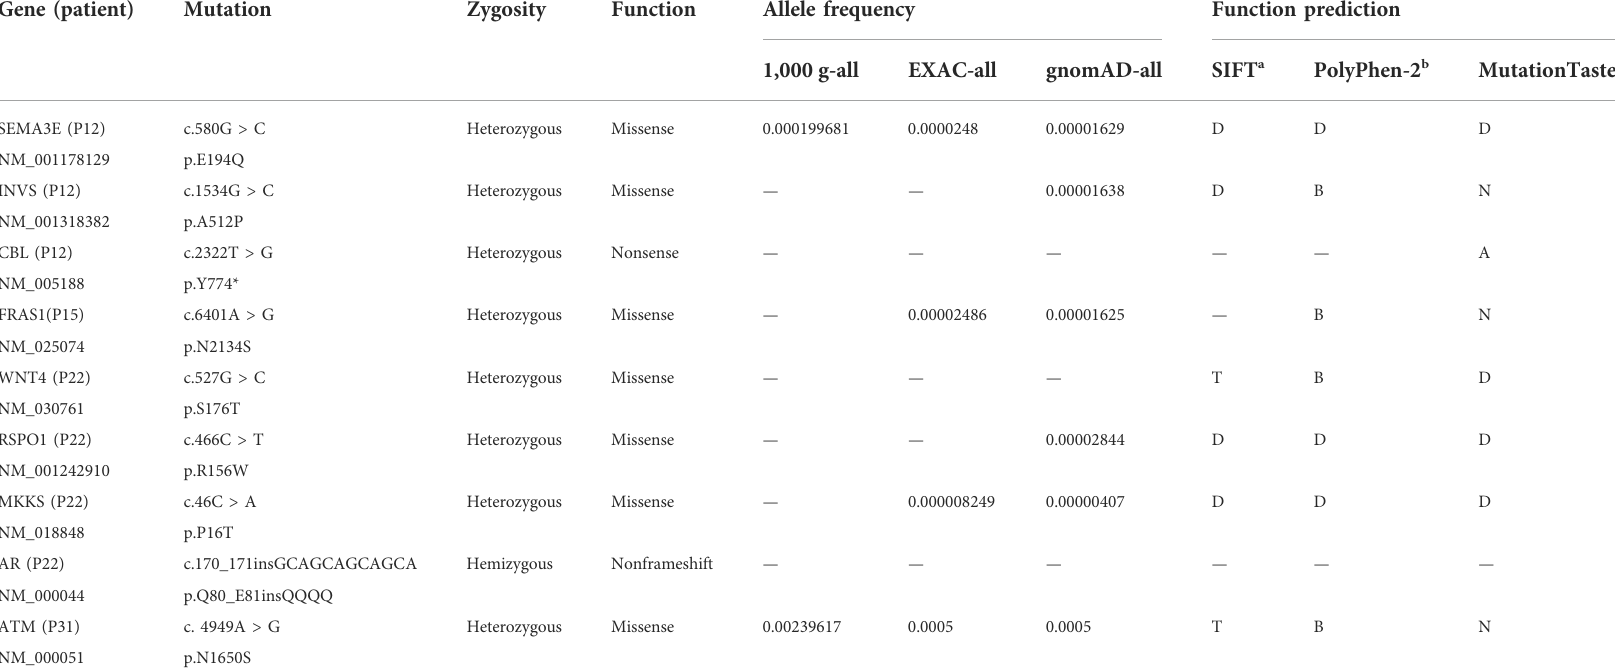
TABLE 2 Mutation of genes identi fi ed in hypospadias CAVD patients. Gene